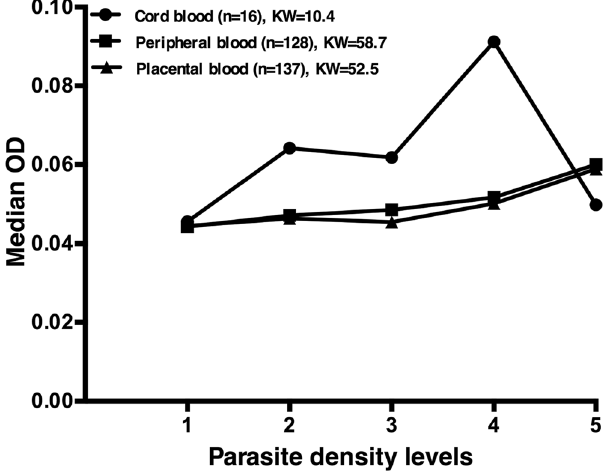
Figure 1. Pf HRP2 levels and parasite density: variation of the median optical density (OD) for Pf HRP2 detection by ELISA in cord blood according to parasite density levels in cord, maternal peripheral and placental blood by qPCR. Parasite densities were categorized using interquartile ranges (IQR) as follows: 1 = negative;